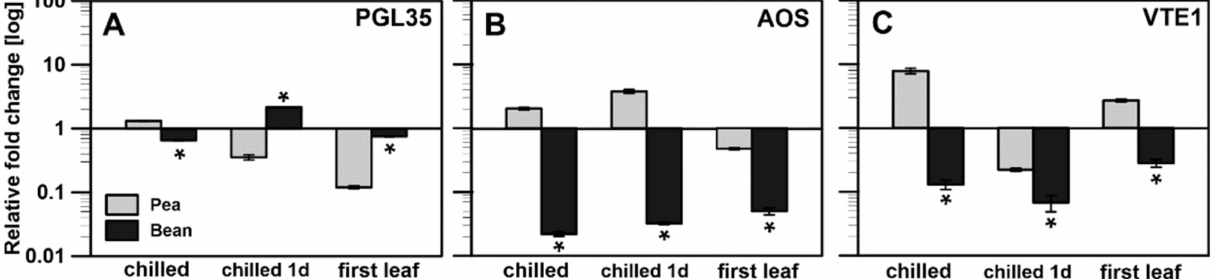
Figure 5. Transcript levels of genes: PGL35 ( A ), AOS ( B ) and VTE1 ( C ) in pea and bean normalised to 1 in control conditions; chilled: after seven days of chilling treatment, chilled 1d: after first night of chilling stress and first green leaves after three days of development in light. The data are mean values ± SD from three independent experiments; bean results marked with an asterisk (*) differ significantly at p = 0.05 from corresponding pea results in equal growth conditions/stage of